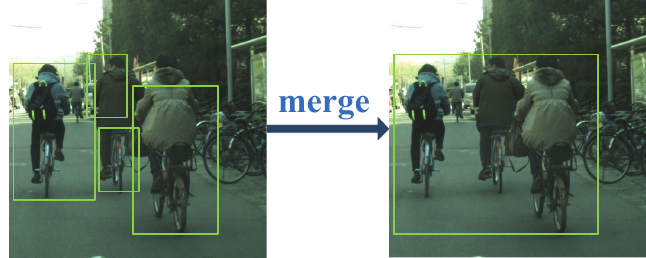
Figure 3. One example of the process of merging bounding